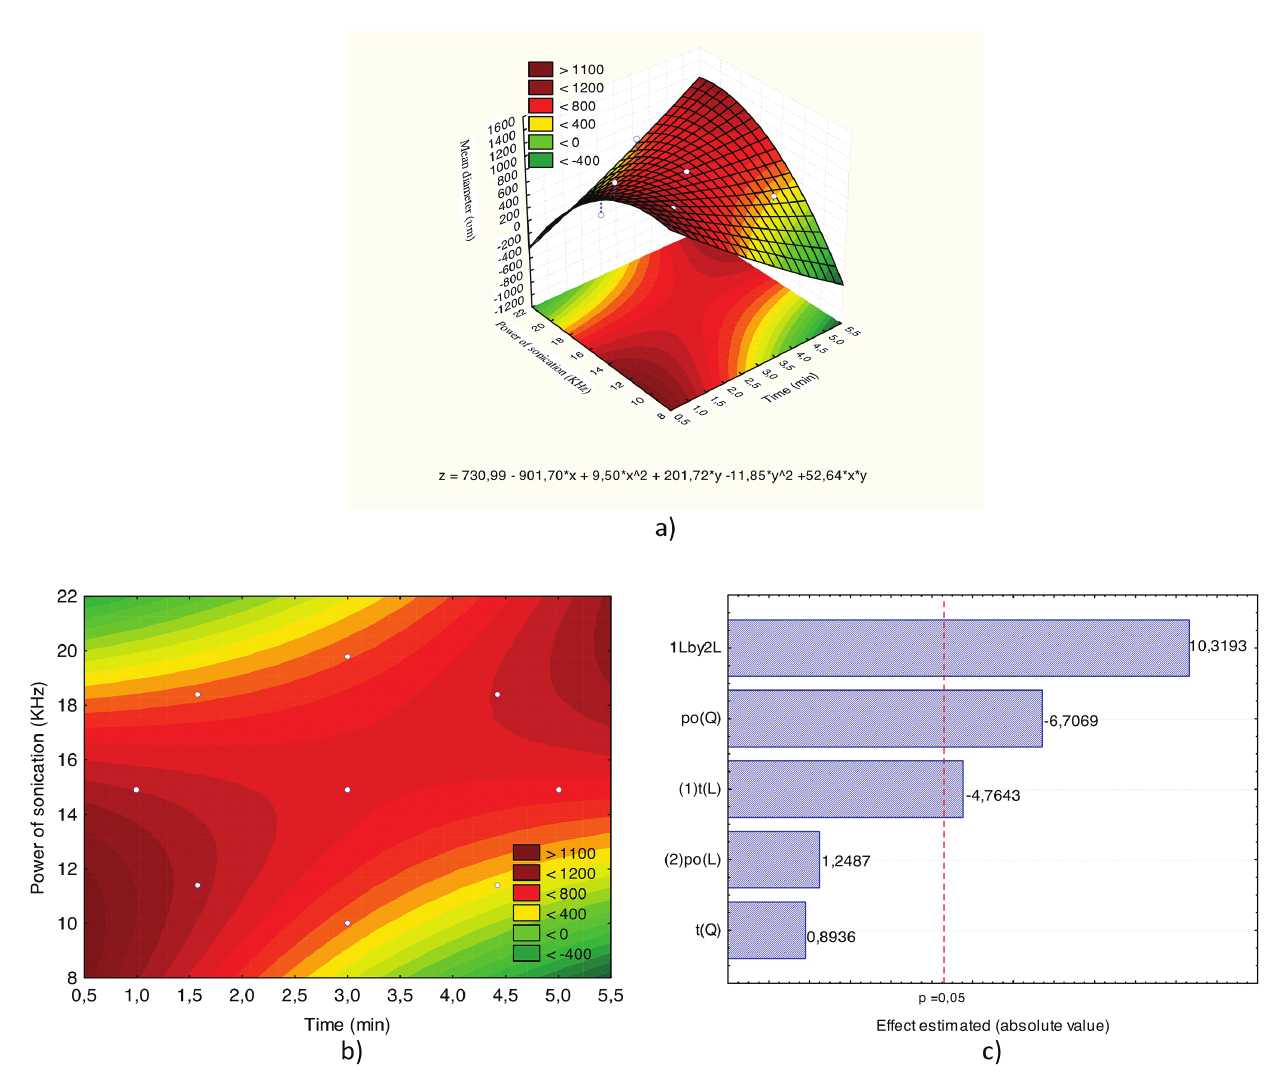
FIGURE 2 - Response surface (A), contour curve (B) and Pareto chart (C) for the mean diameter of liposomes depending on the power and sonication time (liposomes containing 100% - 0.05 g/10 mL soy phosphatidylcholine